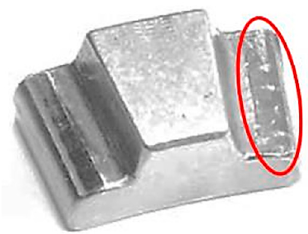
Figure 4. Comparison of the unworn surface of the lever (left side) with worn (right side highlighted in red).